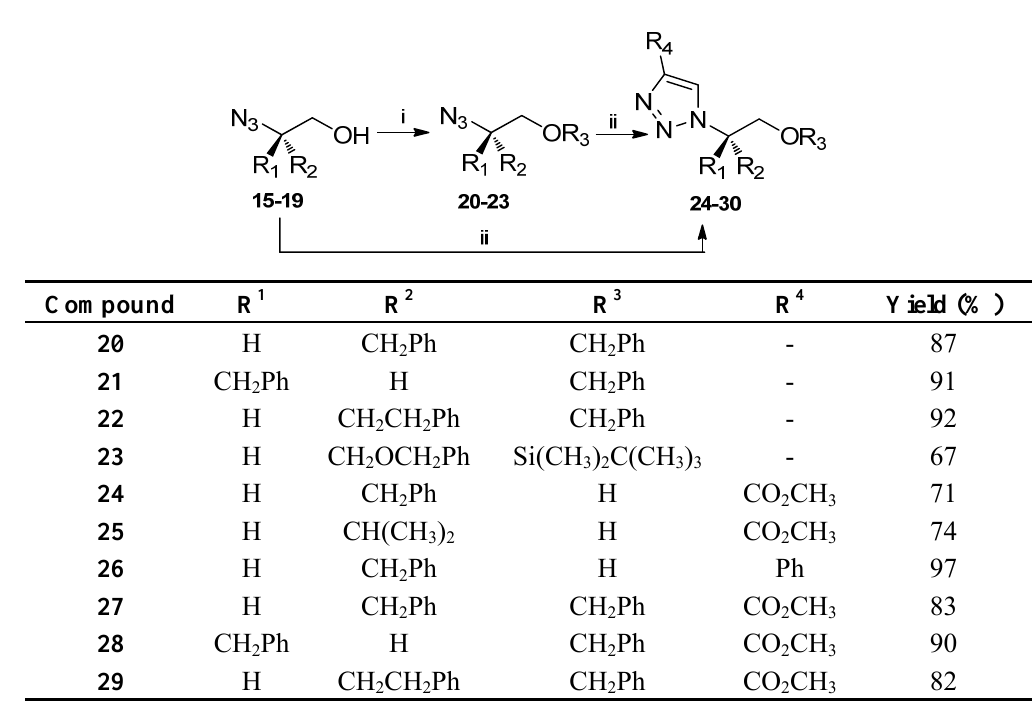
Table 2. Synthesis of